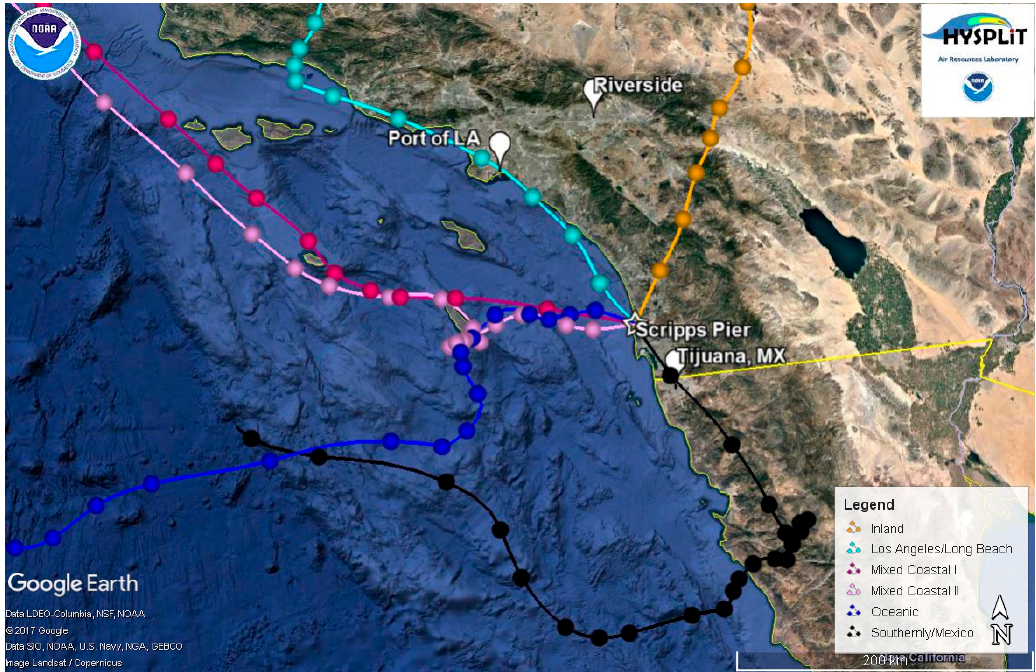
Figure 1. Representative 48-h back trajectories taken at 200 m for the different air masses observed during the measurement campaign: ( a ) Inland (orange; taken 22 September 2009 at 6:00); ( b ) Los Angeles/Long Beach (cyan; taken 11 September 2009 at 9:00); ( c ) Mixed Coastal I (magenta; taken 03/09/2009 at 21:00); ( d ) Mixed Coastal II (light pink; taken 15 September 2009 at 0:00); ( e ) Oceanic (dark blue; taken 14/09/2009 at 12:00), and ( f ) Southerly/Mexico (black; taken 01 September 2009 at 12:00). Points represent 2-h time intervals.